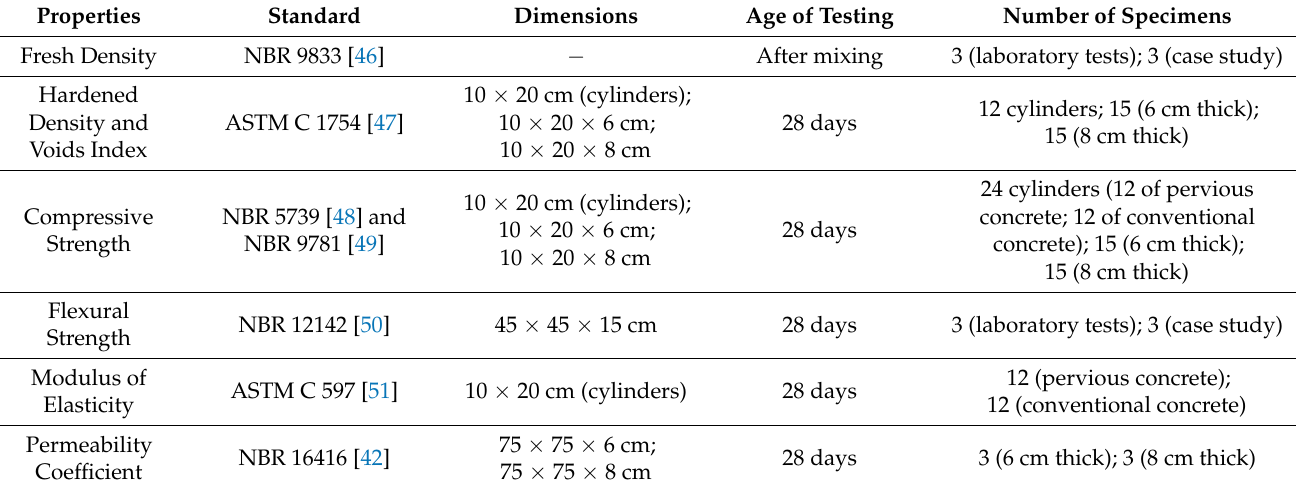
Table 4. Dimensions and specifications of the specimens considered.